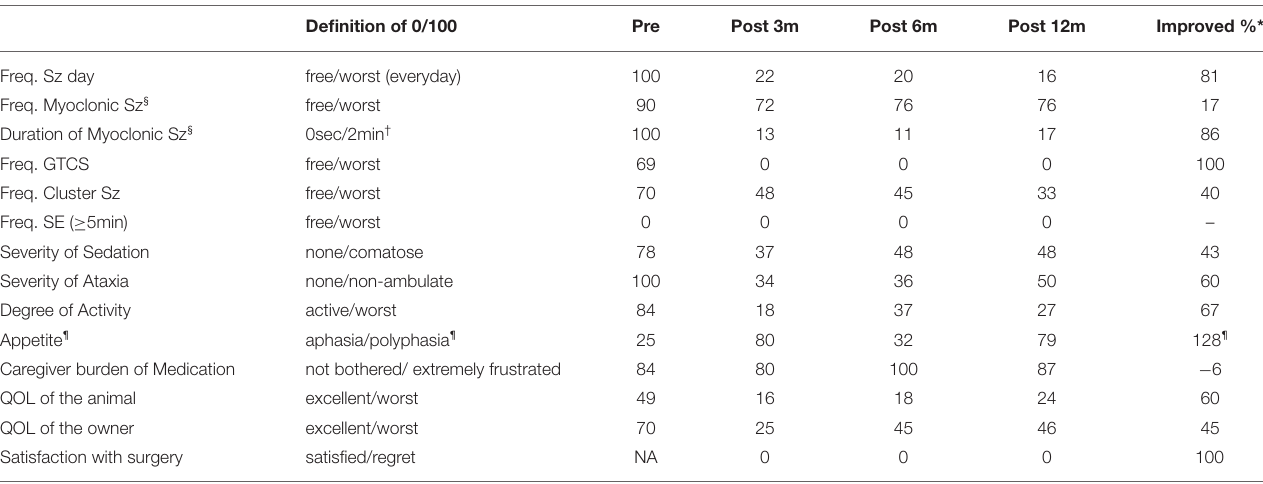
FIGURE 3 | Changes in averaged daily seizure frequency (seizure/day) for preoperative (Pre) to postoperative 12 months (P1–P12). The preoperative seizure frequency (Pre; 7.22 sz/d) was shown as the average for 3-months before surgery. The average one-year postoperative seizure frequency was 1.7 sz/d (76% reduction). FPS (yellow), fencing posture seizures; GTCS (pink), generalized tonic-clonic seizures; MS (purple), myoclonic seizures including generalized, facial myoclonic, and short tonic seizures. TABLE 1 | Result of the visual analog scale